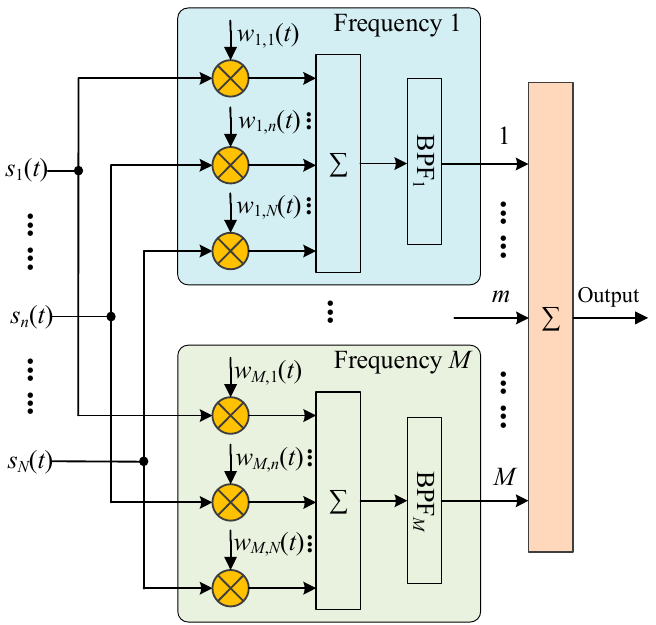
Figure 6. Processing diagram of the improved DBF processor with multi-frequency time delays.